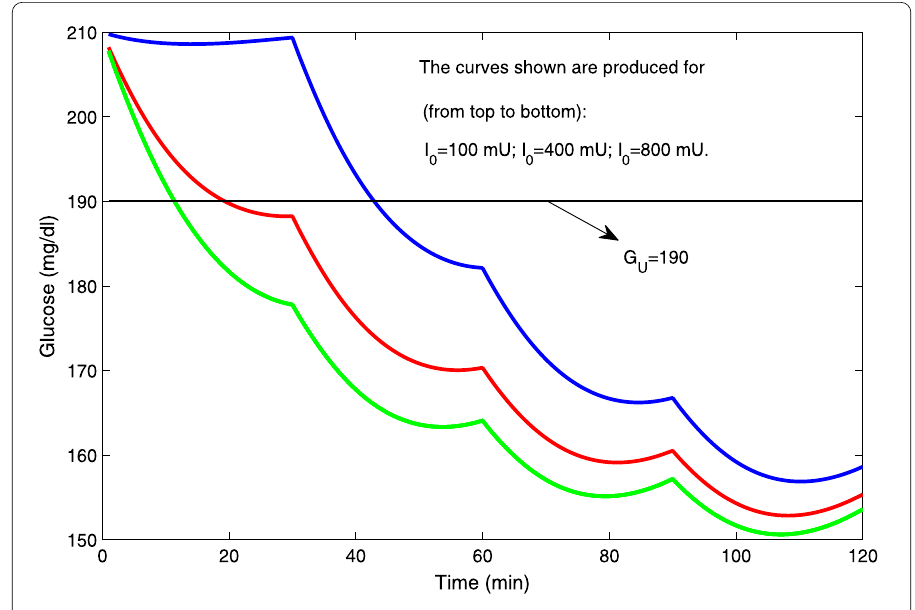
Figure 1 Comparison of the profiles produced by Model (2) with different initial insulin values with G 0 = 210 mg/dl, σ = 500 mU and τ = 30